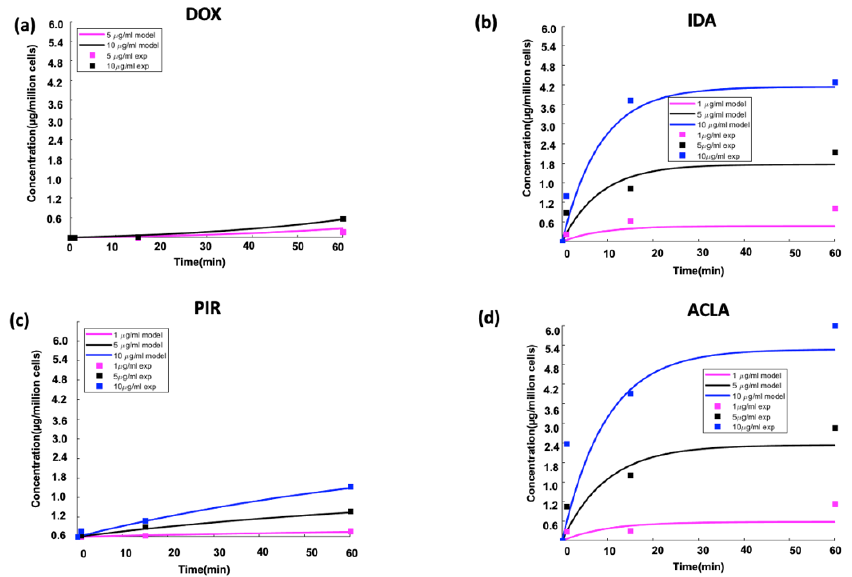
Figure 11. Cell uptake kinetics depend on drug. In vitro drug uptake of SVR (angiosarcoma) cells for ( a ) doxorubicin (DOX), ( b ) idarubicin (IDA), ( c ) pirarubicin (PIR), and ( d ) aclarubicin (ACLA) at extracellular concentrations of 1, 5 and 10 µ g/mL. Uptake is shown for 60 min, which is a typical time used for hyperthermia-triggered delivery by TSL. Figure reproduced from [172] (published under CC BY